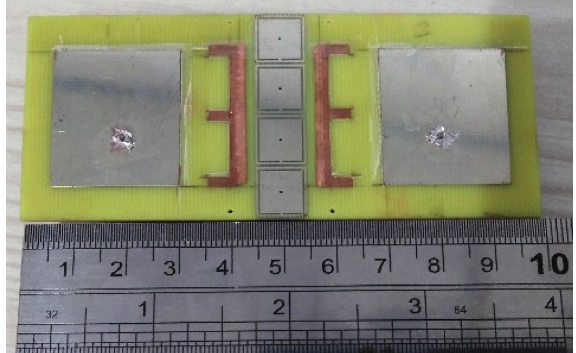
Figure 11: Photograph of the fabricated prototype.